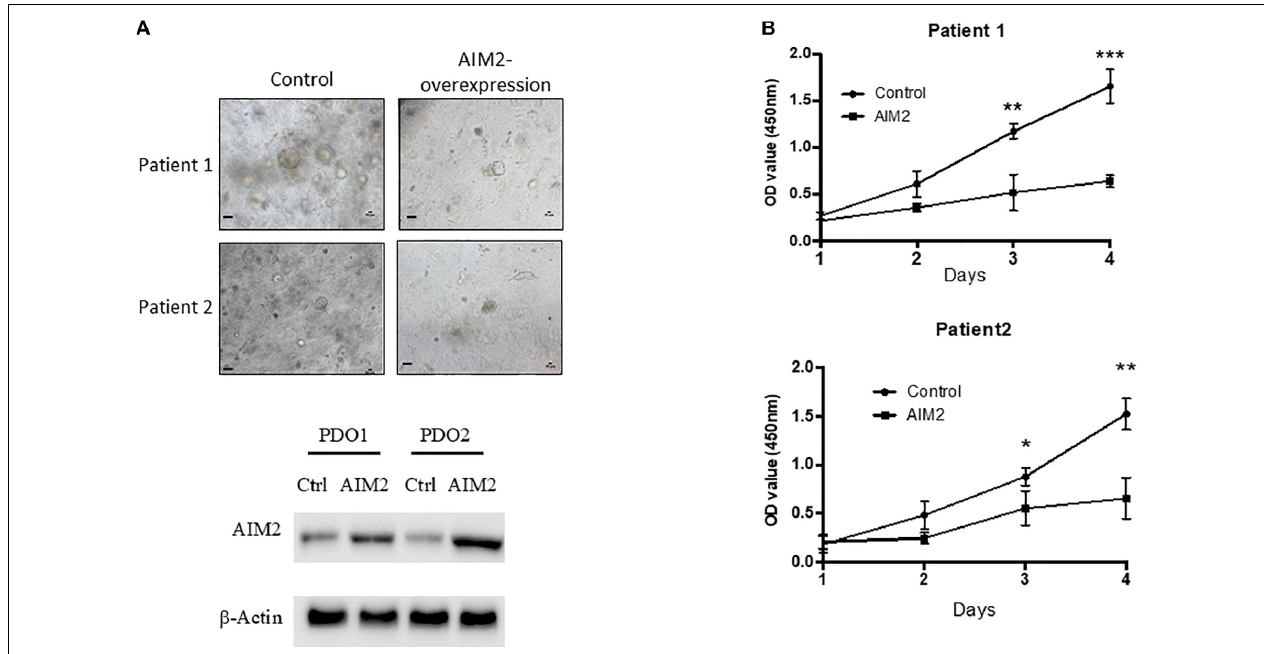
FIGURE 6 | Restoration of AIM2 expression inhibits PDOs growth in BRAF-mutant CRC. (A) Two BRAF-mutant CRC PDOs were constructed and transfected with AIM2 overexpression vectors and planted into Matrigel under the HISC condition (WENRg + nicotinamide + A83-01 + SB202190). The morphology of PDOs was recorded 14 days after cell plantation into Matrigel. Scale bar: 100 µ m. The AIM2 restoration was confirmed by WB. (B) The growth curves of BRAF-mutant CRC PDOs ( n = 3, Student’s t -test). * p < 0.05, ** p < 0.01, *** p <